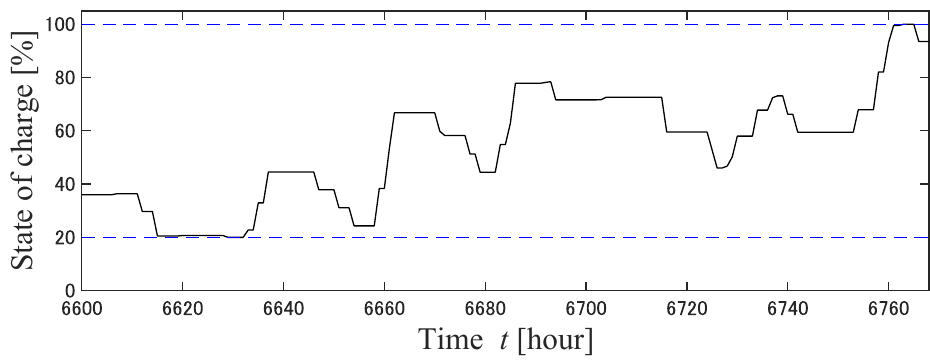
Figure 28. SOC of BESS from January 1 to 7 (Case 2). Table 8. EV charging rates (when mitigation conditions are